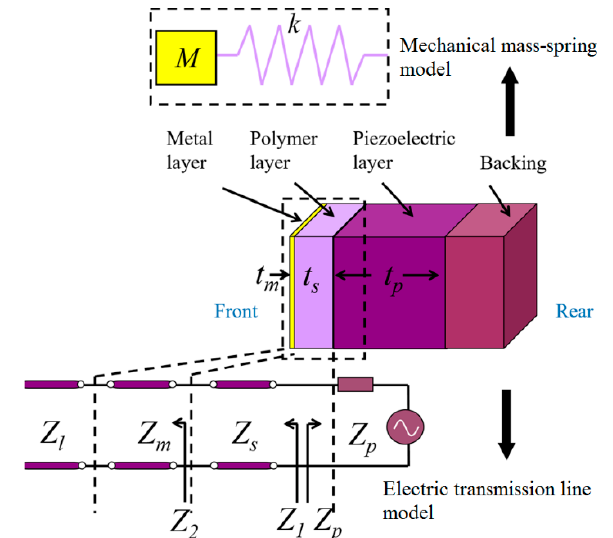
Figure 8. Schematic of a piezoelectric element with two-layer matching showing mechanical (spring-mass) and electrical (transmission line) equivalent models. Reprinted from [154], with the permission of AIP Publishing.